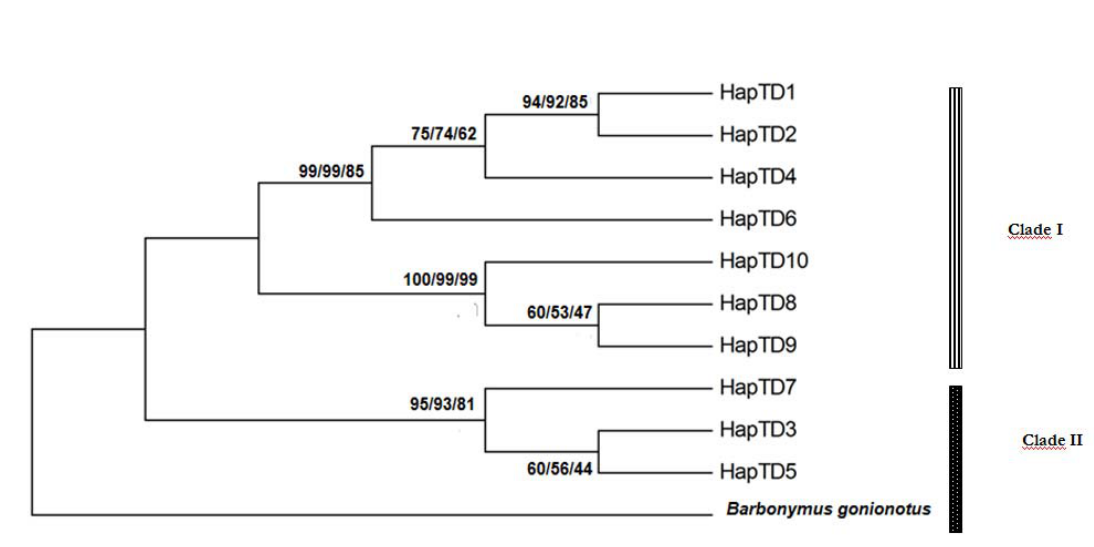
F IGURE 1. Map showing the sampling locations of T. duoronensis used in the mtDNA diversity study A: Lundu, B: Semadang, C:Bau, D:Terbat, E:Entabai River, F:Bakun Dam, G:Tuyo River, H:Kg. Pa Puti.